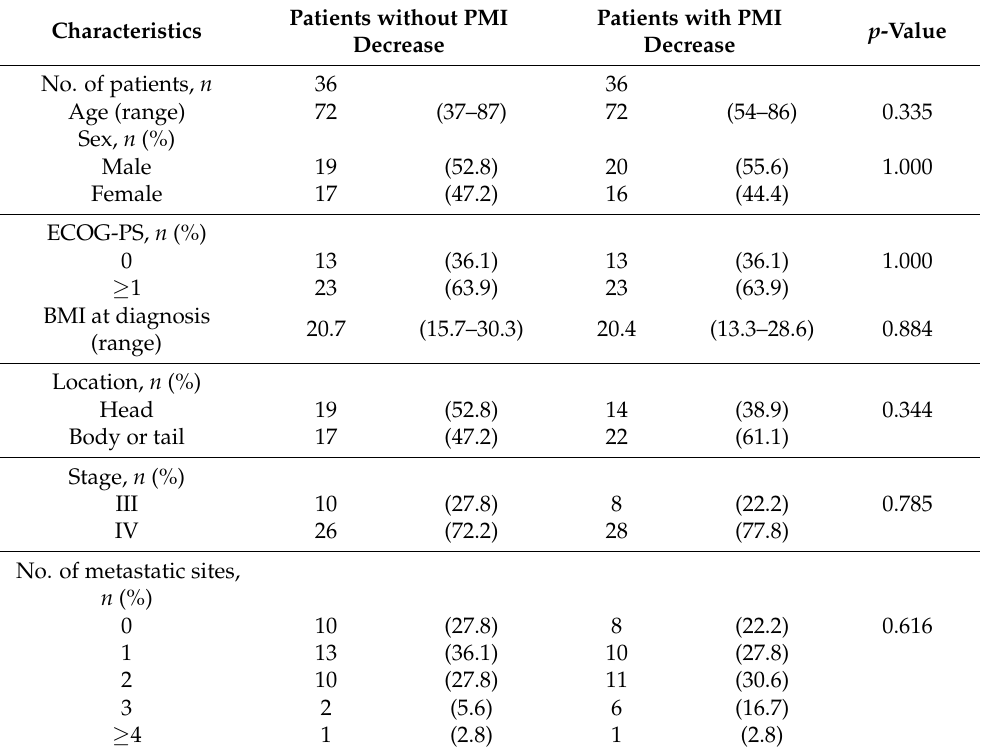
Table 3. Comparison of the clinical characteristics in the patients without or with PMI